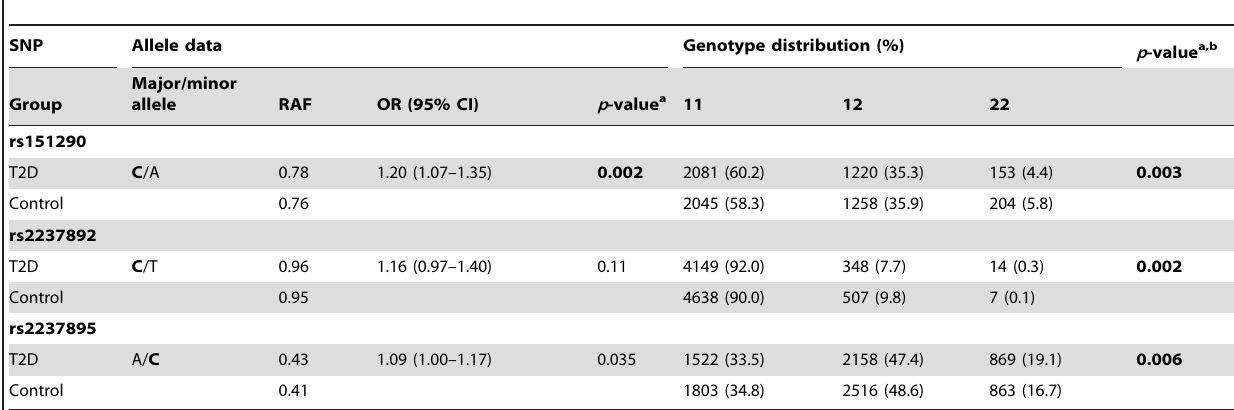
Table 2. Association of the KCNQ1 variants with type 2 diabetes in the Dutch